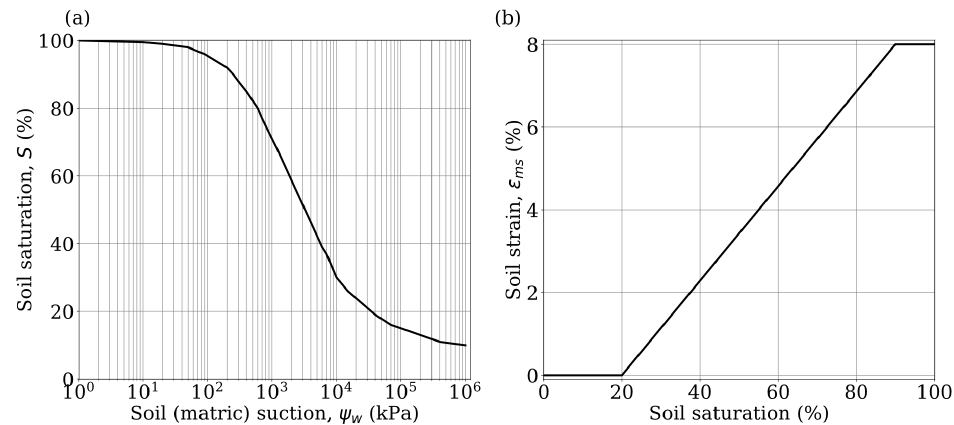
Figure A1. Input material properties of the reactive soil showing ( a ) the soil–water characteristic curve or SWCC from [18] and ( b ) the idealised moisture-swelling curve based on